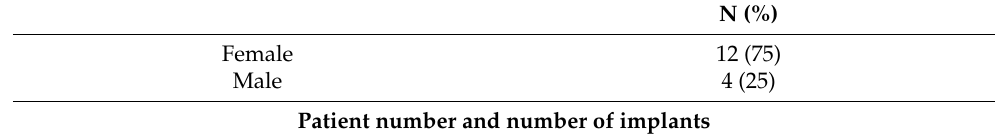
Table 1. Demographic data and dimensions of